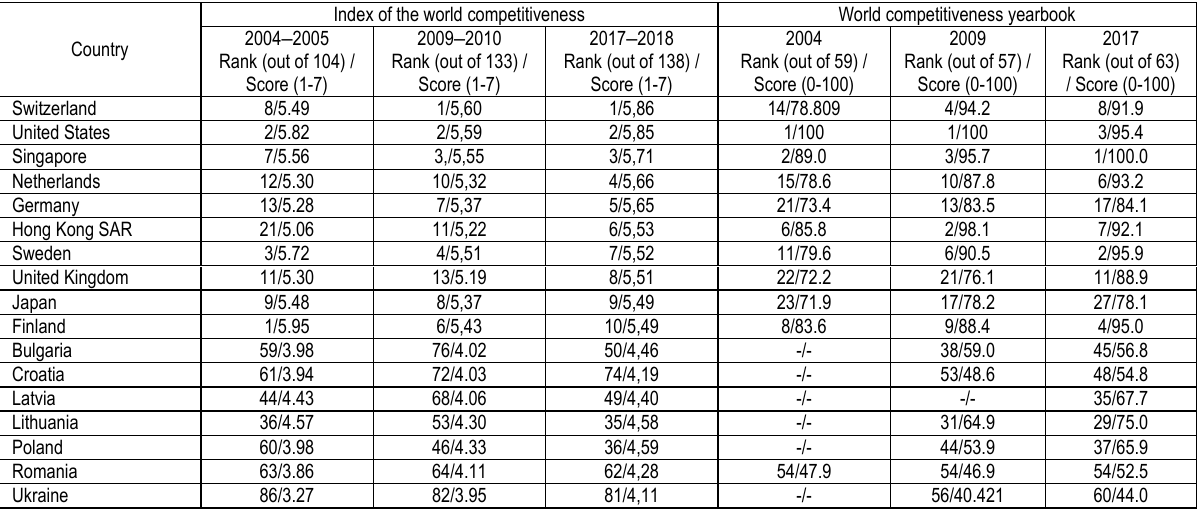
Table 1. Changes in the international competitiveness indices in 2004 ‒ 2017